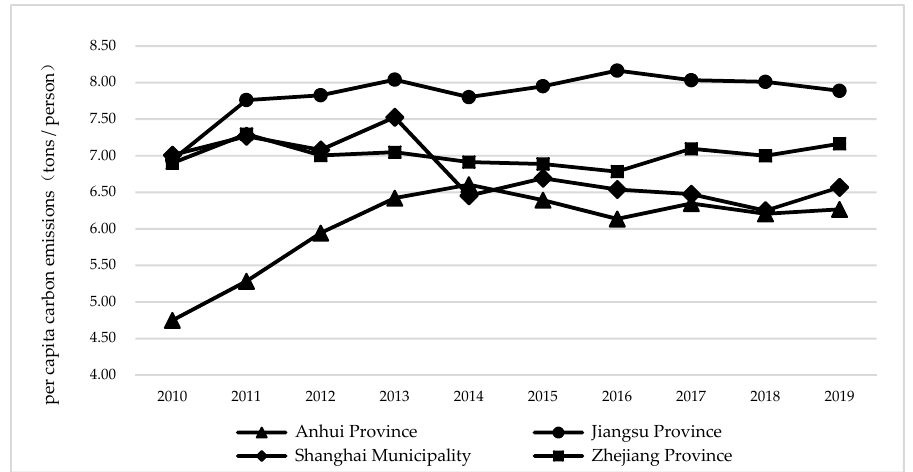
Figure 3. Per capita carbon emission of three cities in the Yangtze River Delta.